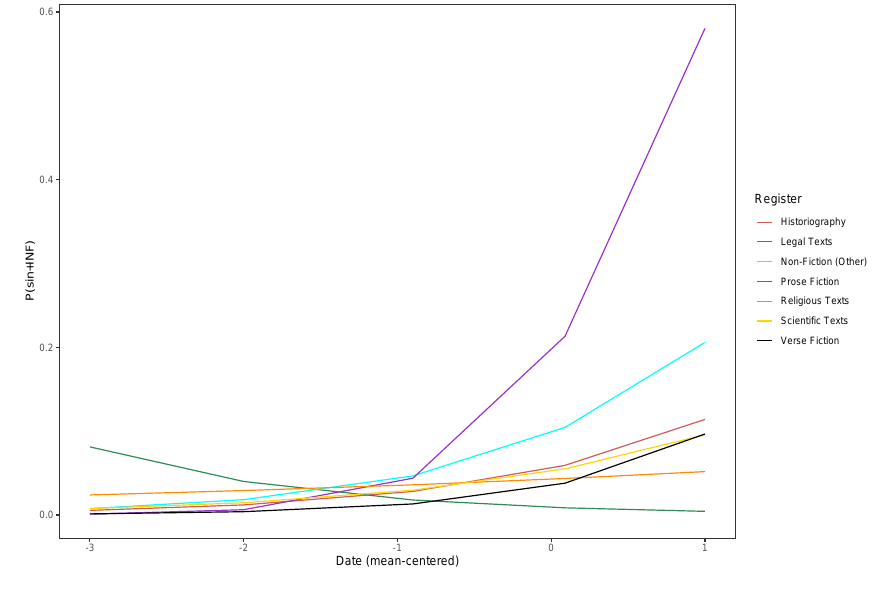
Figure 3. Interaction effect of date and